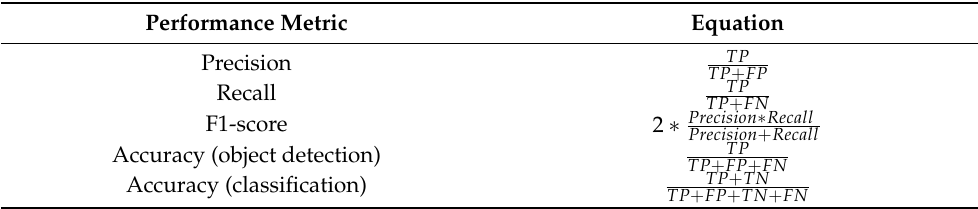
TP + FP TP + FN Precision + Recall